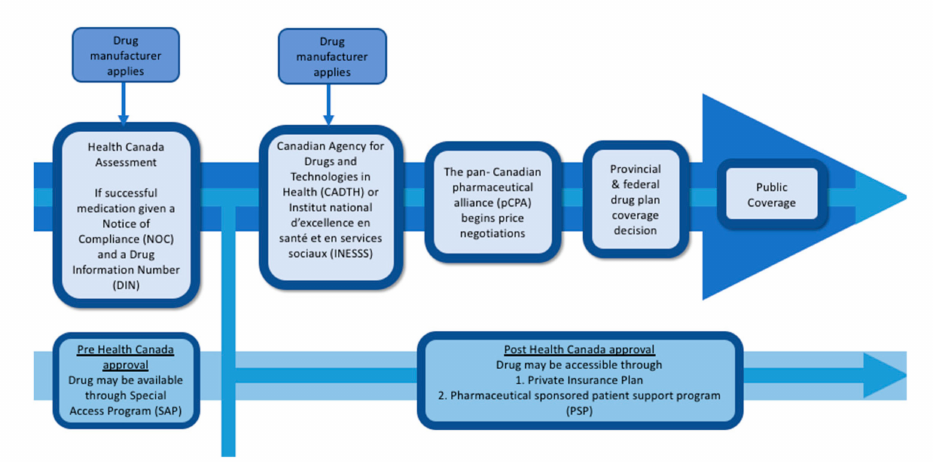
Figure 1. Institutions involved in drug assessment and addition to public formulary in